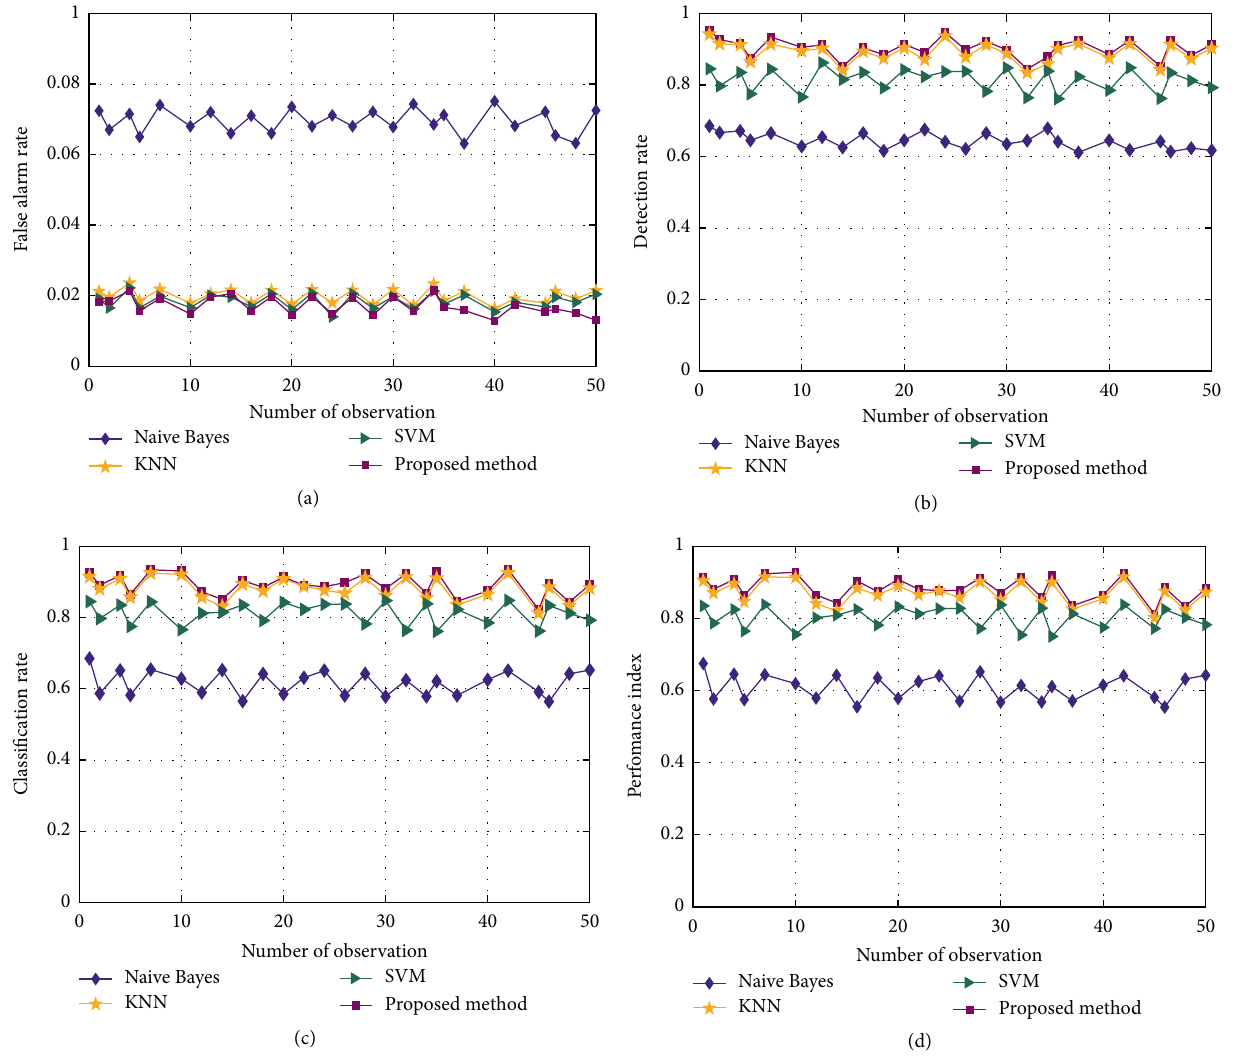
Figure 13: Comparisons of proposed method with other competent methods (a) FAR, (b) DR, (c) CR, and (d)